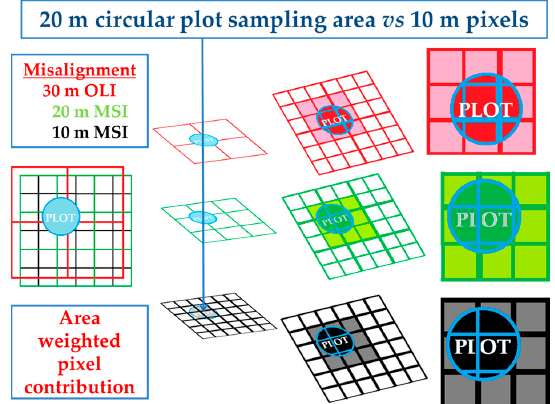
Figure 6. Geometric procedure used to compare pixels of Landsat-8 OLI (30 m) and Sentinel-2A MSI (20 m and 10 m) with field data plots of 20 m of diameter: 30 m and 20 m pixels are resampled to 10 m and the 20 m of diameter of plot area covers up to 9 pixels. The area that is intersected by the circle in each affected pixel is used to compute its contribution (weight) to the final reflectance value to be compared to the field radiometry.